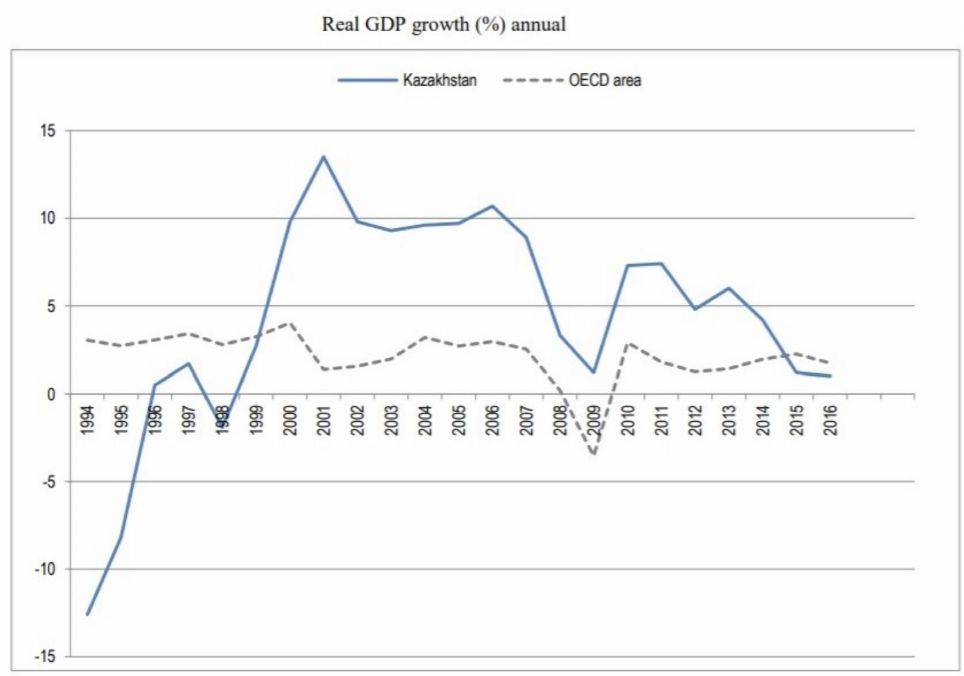
Figure 6. Growth performance, 1994–2016 where OECD is the Organization for Economic Co- operation and